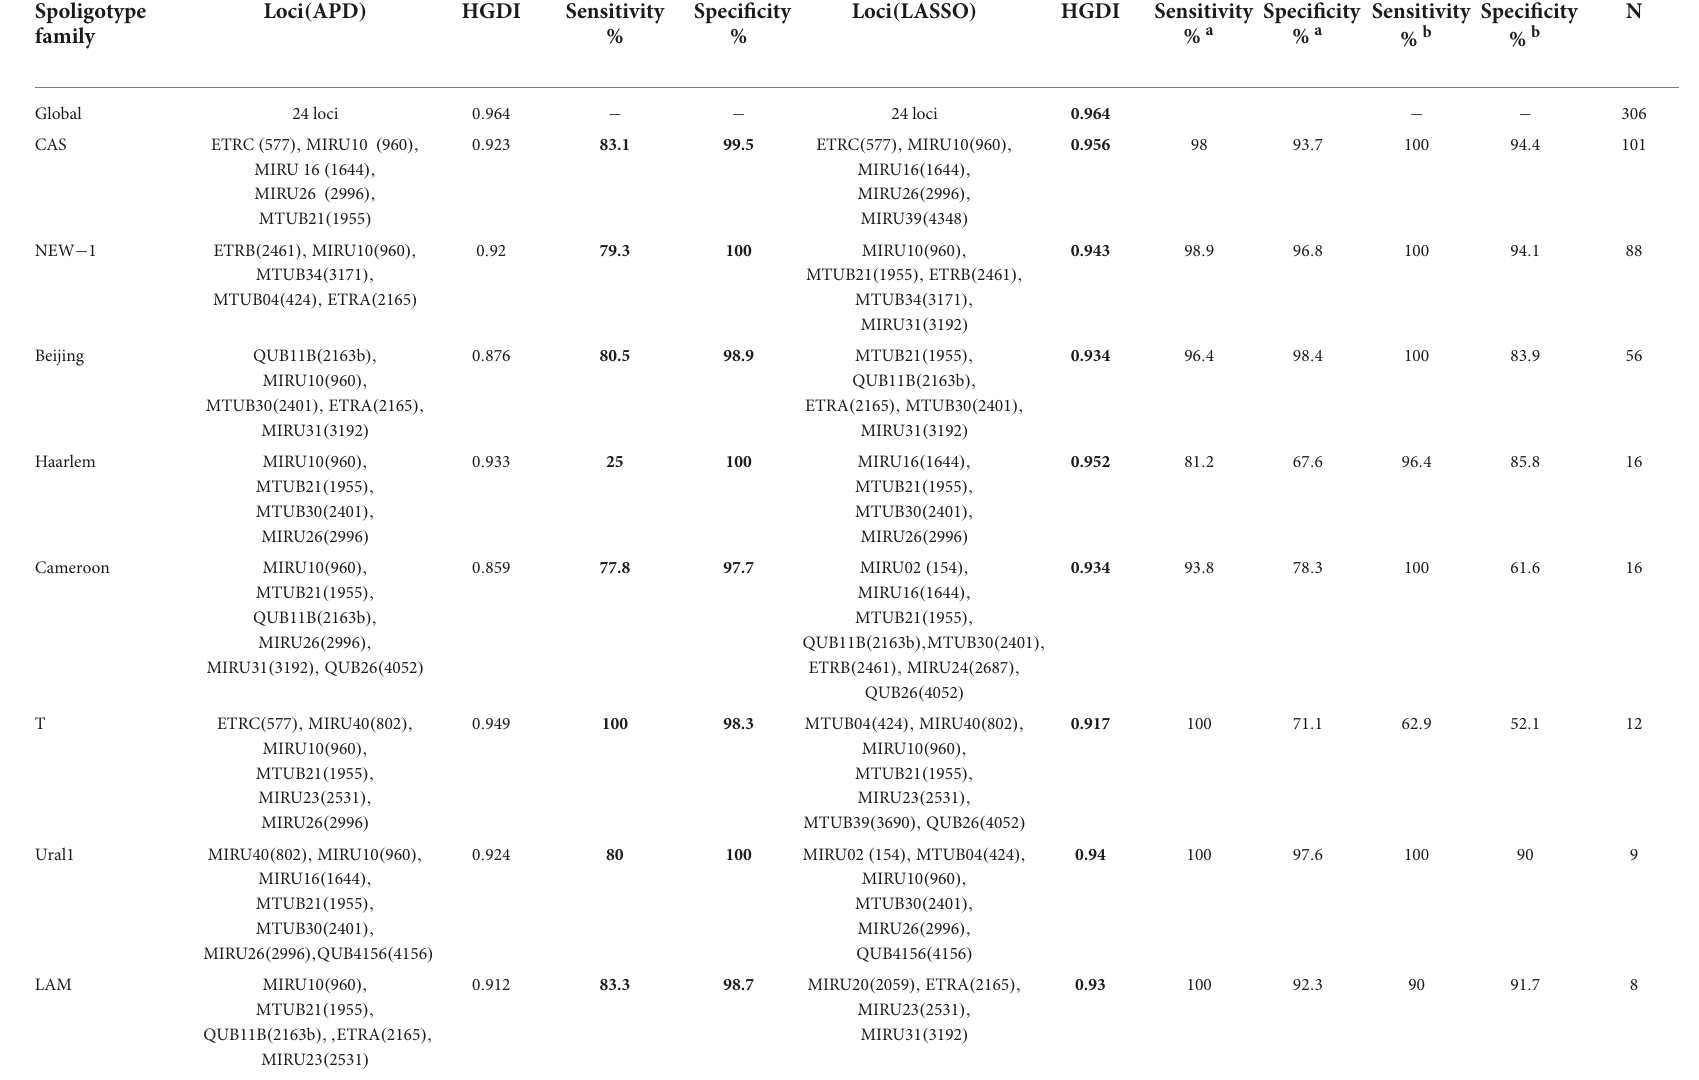
TABLE 1 HGDI values of proposed genotype-specific MIRU-VNTR loci based on APD and LASSO regression